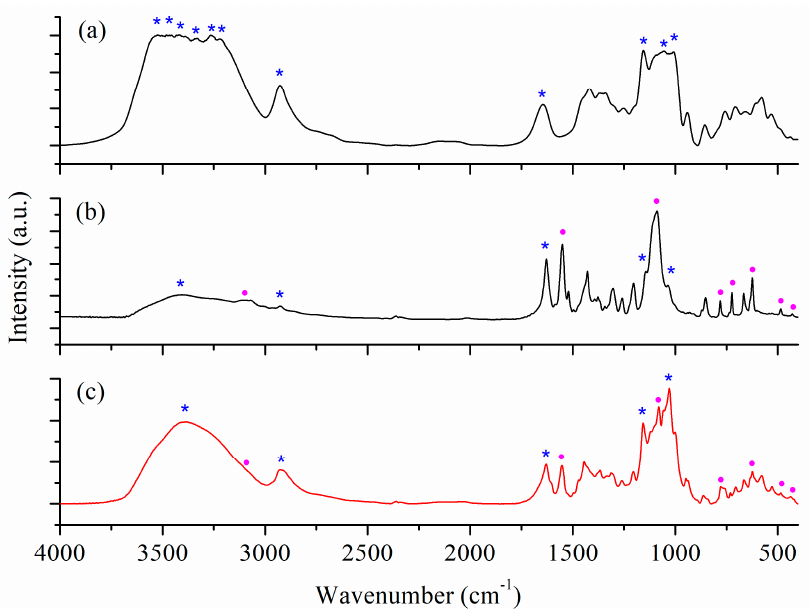
Figure 6. IR spectra of β -CD (bands marked with *) ( a ) and inclusion complexes ( 1a )@ β -CD ( b ) and ( 2a )@ β -CD ( c ) registered in KBr discs. The bands corresponding complexes ( 1 ) and ( 2 ) are marked with •